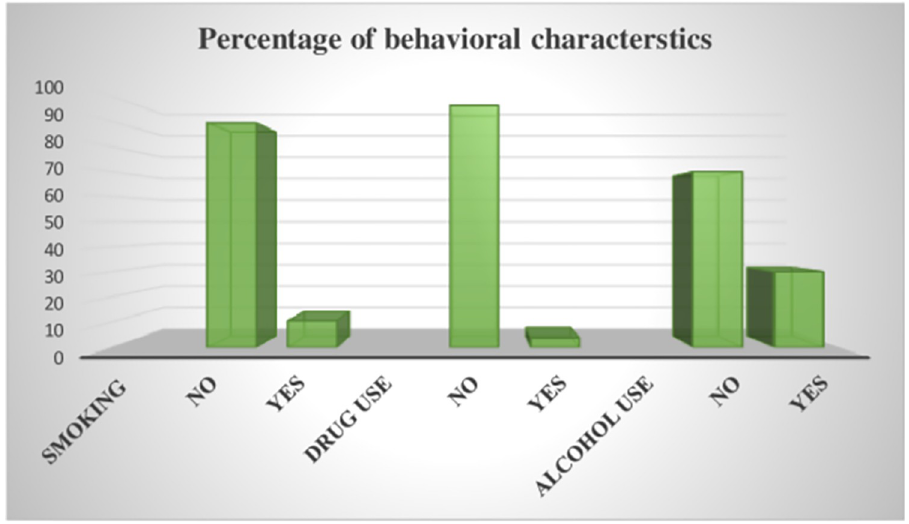
Fig 2. Behavioral characteristics of MDR-TB patients in North West Ethiopia, September 2010 to July 2020.